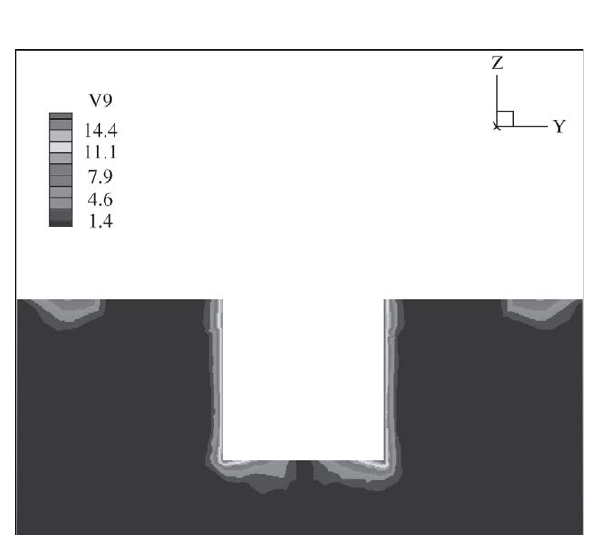
Figure 3. Flow lines of the material in the insert region of the tool.